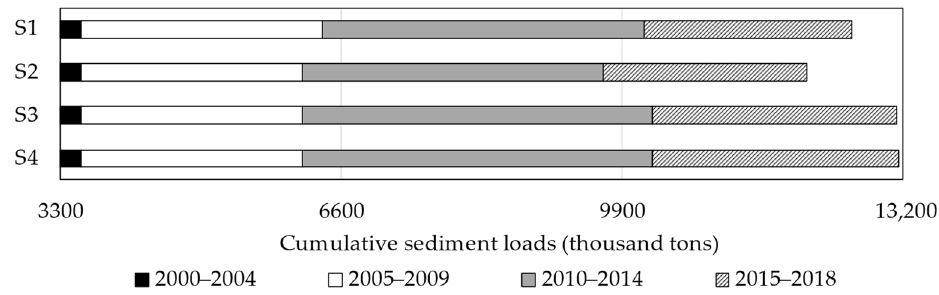
S4 used the updated land- use information in the simulation, the cumulative sediment 232 thousand tons, corresponding to 0.8 tons/ha. After 2010, S3 and S4 used updated land- 2014 changed from 3772 thousand tons in S1 to 3526 thousand tons in S2, 4105 thousand tons in S3, and 4105 thousand tons in S4.